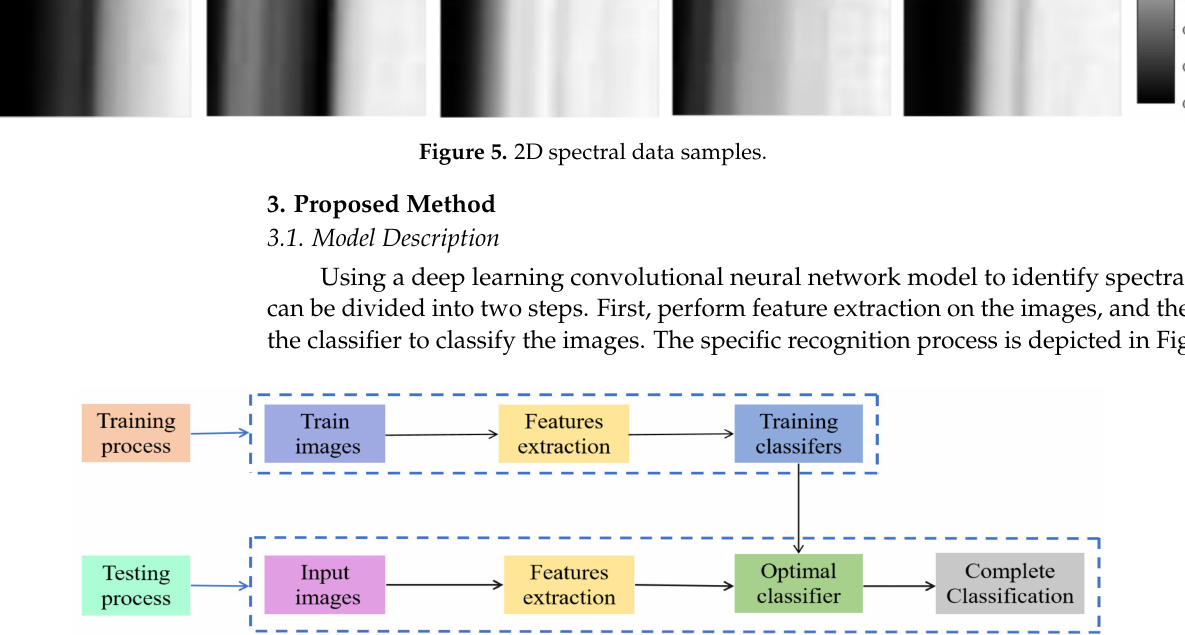
Figure 6. Convolutional neural networks (CNN) recognition